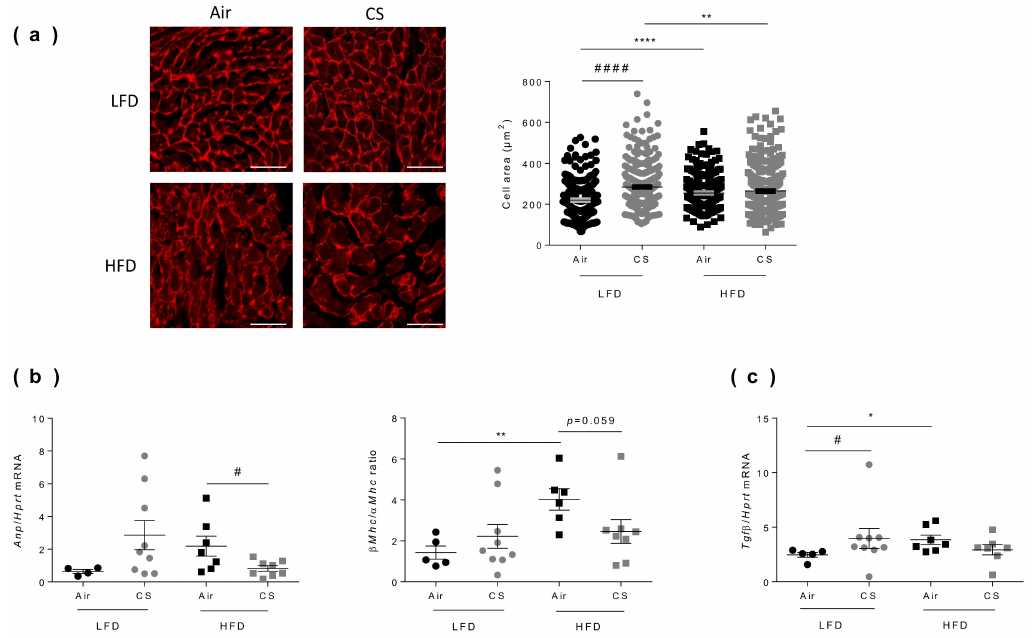
Figure 5. Chronic cigarette smoke (CS) exposure restricts obesity-induced cardiac hypertrophy. (a) Cardiomyocytes transverse section areas were stained by rhodamin labeled-wheat germ agglutinin (WGA) (left panel) and cells’ area were quantified (right panel) ( n = 5–8 mice per group; 224-346 cells per group). Scale bar corresponds to 50 µ m. (b) Fetal gene program expression of Atrial Natriuretic Peptide (Anp) and β / α Myosin Heavy Chain (Mhc) ratio were quantified by RT-qPCR ( n = 4–9 mice per group). (c) Fibrosis was measured by quantification of transforming growth factor beta (Tgf β ) expression by RT-qPCR ( n = 6–9 mice per group. Data are expressed as individual and mean ± SEM. values. * p < 0.05, ** p < 0.01, **** p < 0.0001, *correspond to diet e ff ect (HFD vs. LFD), # p < 0.05, #### p < 0.0001, #correspond to CS e ff ect (CS vs.